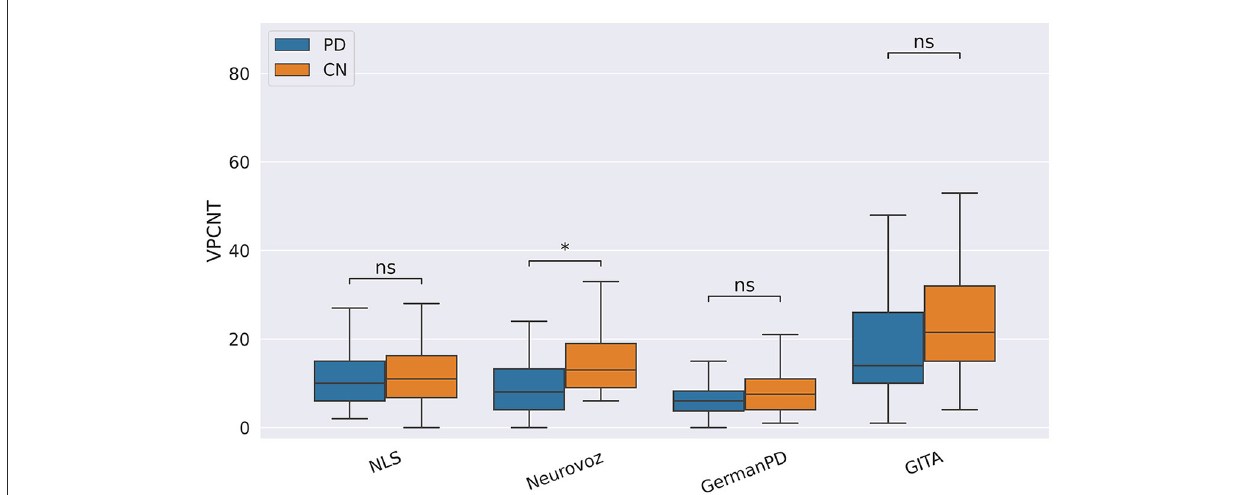
FIGURE7 Boxplots with statistical annotations representing the verb phrase count (VPCNT) on NLS, Neurovoz, GermanPD, and GITA from the SS task. Horizontal lines represent the median, the top ends represent the upper quartile, and the bottom ends represent the lower quartile. Statistically significant differences between groups after Benjamini–Hochberg correction for VPCNT are reported in Table 6 and highlighted below using asterisks. VPCNT, verb phrase count; CN, control group; PD, Parkinson’s disease; SS, spontaneous speech; ns, not significant.